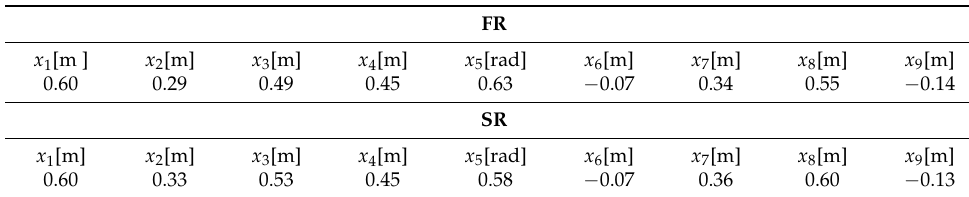
Table A26. Optimum design variables obtained by the best and the worst CHTs for study case 1: Four-bar linkage mechanism.